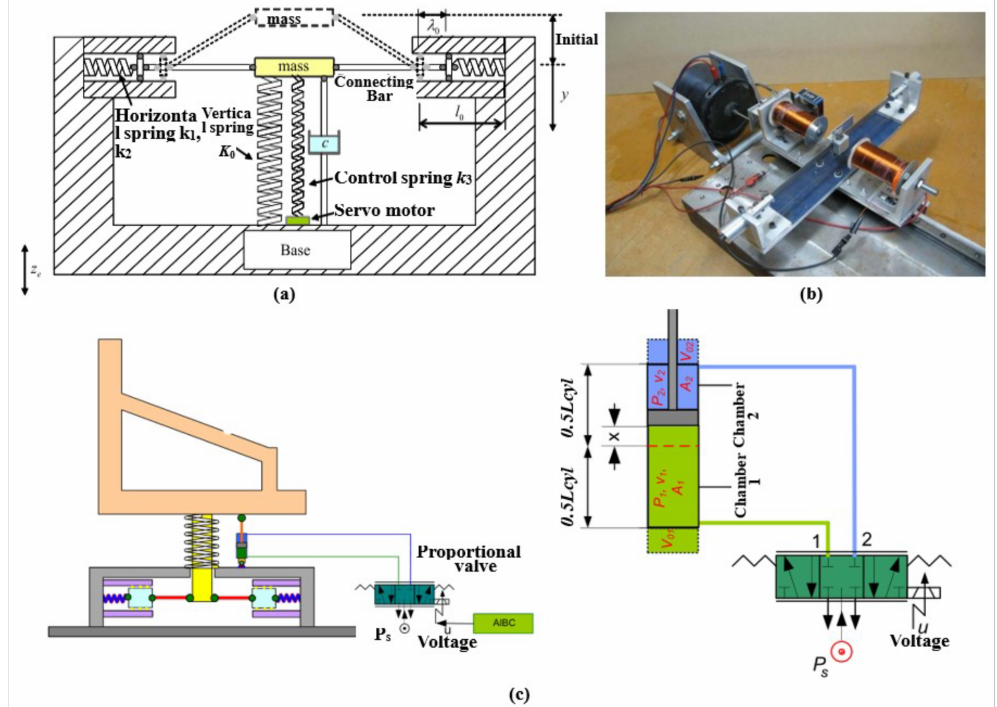
Figure 8. Negative-stiffness structures with active control in ( a ) Simplified schematic diagram of active control, ( b ) Experimental device for active control of negative stiffness structure and ( c ) Negative stiffness structure of active seat control. Reprinted/adapted with permission from Ref. [73]. Copyright 2014 Elsevier Ltd., Xiuting Sun and Jian Xu. Reprinted/adapted with permission from Ref. [74]. Copyright 2009 Elsevier Ltd., N. Zhou and K. Liu. Reprinted/adapted with permission from Ref. [76]. Copyright 2013 Elsevier Ltd., Le Thanh Danh and Kyoung Kwan